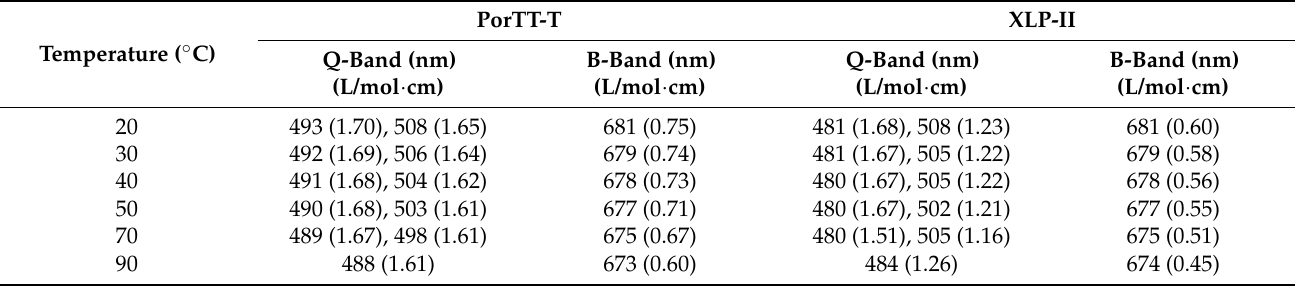
Figure 2. UV-Vis spectra of PorTT-T and XLP-II. ( a , b ) Absorption in chlorobenzene (1 × 10 − 5 mol/L) at different temperatures. ( c ) Normalized absorption of PorTT-T and XLP-II in CF and ( d ) absorption of films of PorTT-T and XLP-II. ( e , f ) Absorption of films obtained with different post-treatments. Table 1. The data of UV-Vis absorption of PorTT-T and XLP-II in chlorobenzene from 20 to 90 ◦ C (numbers in brackets are the absorption coefficients).